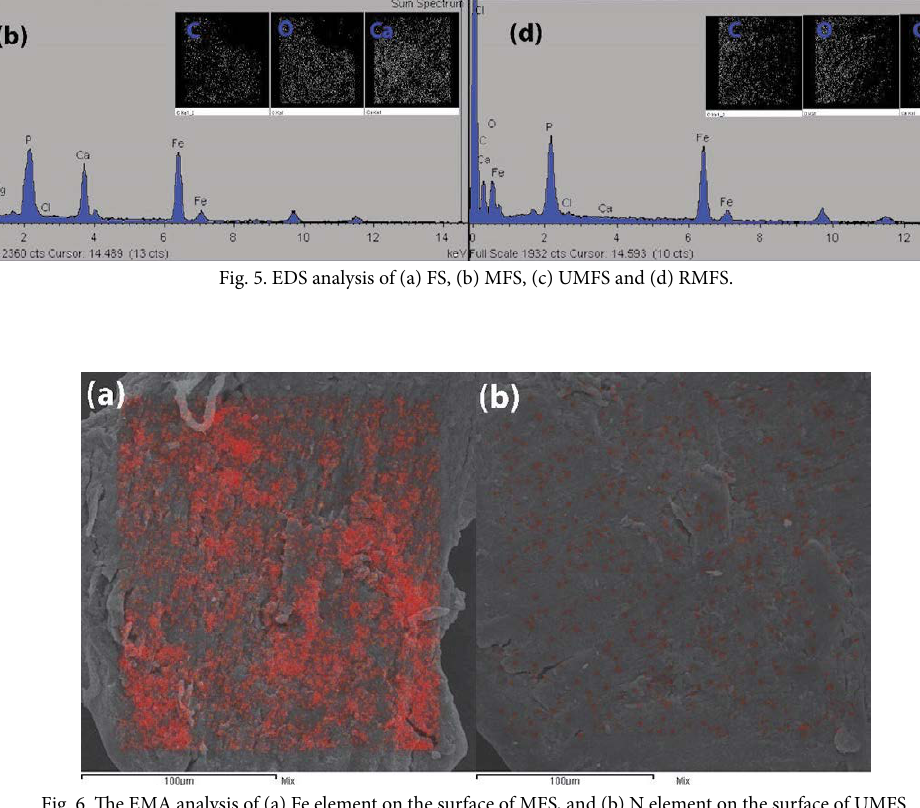
Fig. 6. The EMA analysis of (a) Fe element on the surface of MFS, and (b) N element on the surface of UMFS.